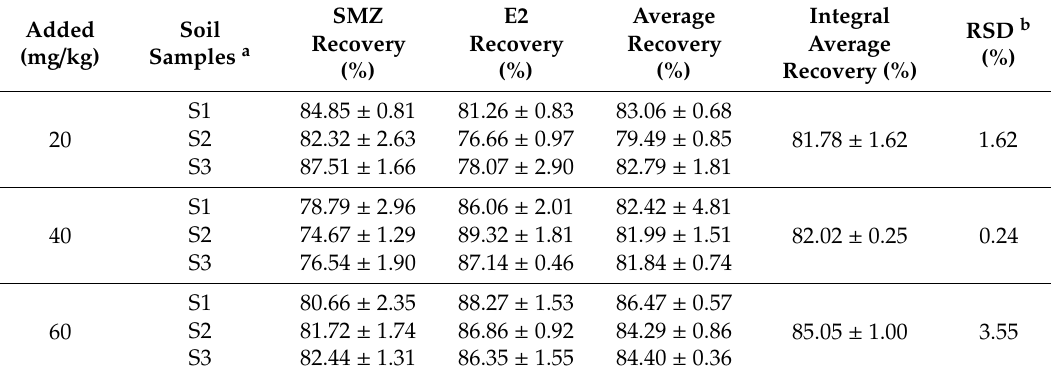
Table 4. Validation results of optimal extraction